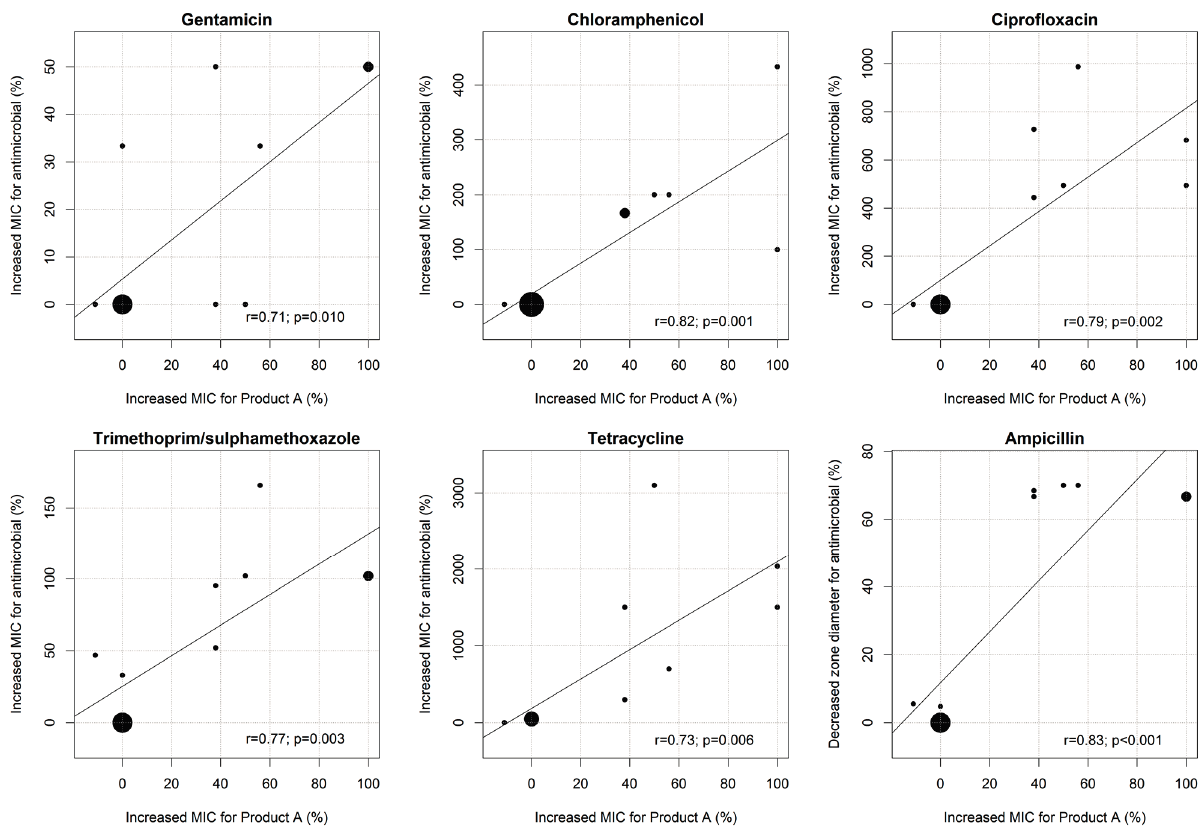
Figure 1. Correlation between changes in MIC for Product A and changes in MIC for gentamicin, chloramphenicol, ciprofloxacin, trimethoprim/sulphamethoxazole, and tetracycline. The size of each dot is proportional to the number of strains. 2.3. Changes in Antimicrobial Susceptibility before and after Exposure to Product